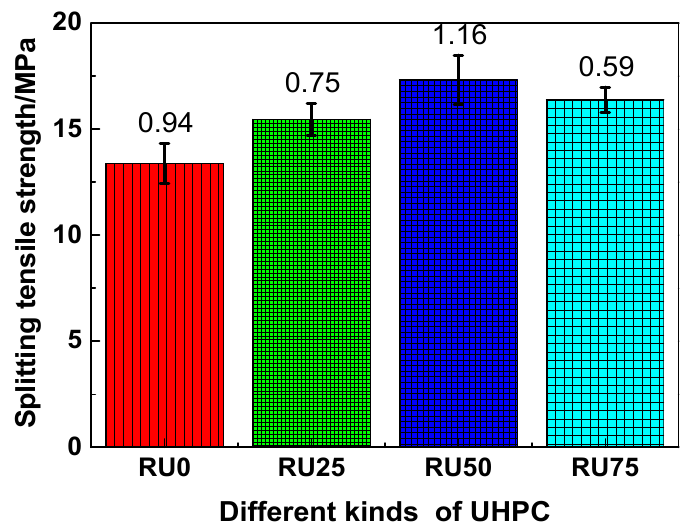
Figure 7. The splitting tensile strength of RS-UHPC with di ff erent contents of GO.